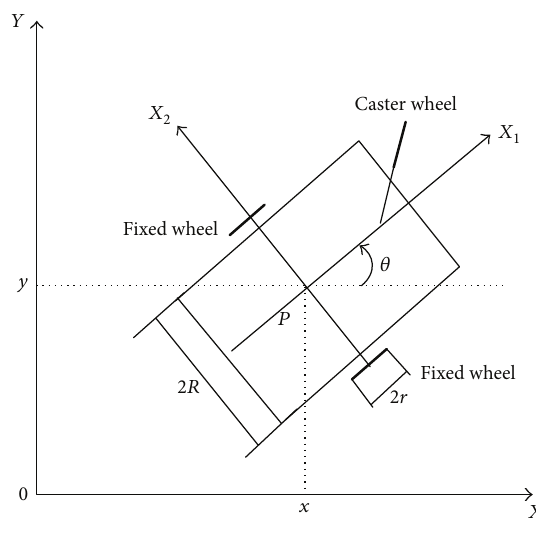
Figure 1: Nonholonomic wheeled mobile